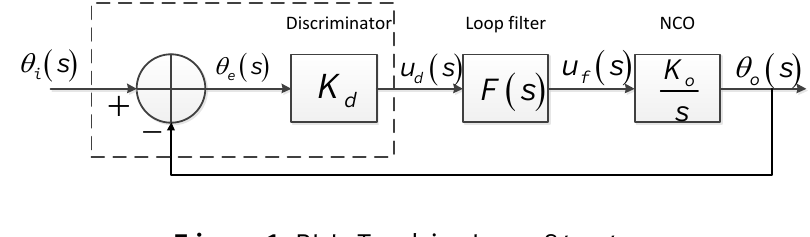
Figure 1. PLL Tracking Loop